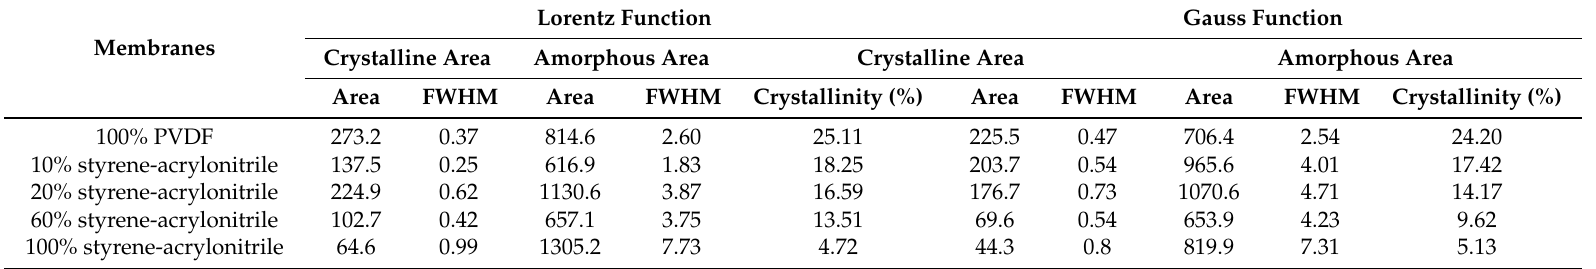
Table 2. Crystalline and amorphous analysis of PVDF/styrene-acrylonitrile membranes by the Lorentz function and Gauss